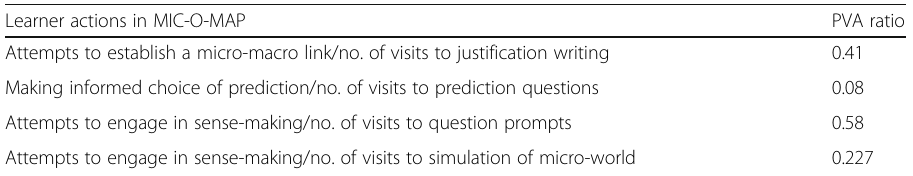
Table 3 Productive value action (PVA) ratio for learners ’ actions in MIC-O-MAP Learner actions in